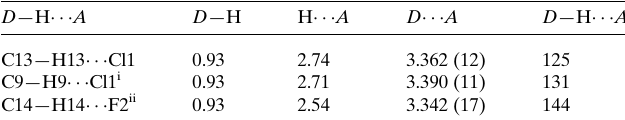
Table 2 Hydrogen-bond geometry (A˚ , (cid:3)